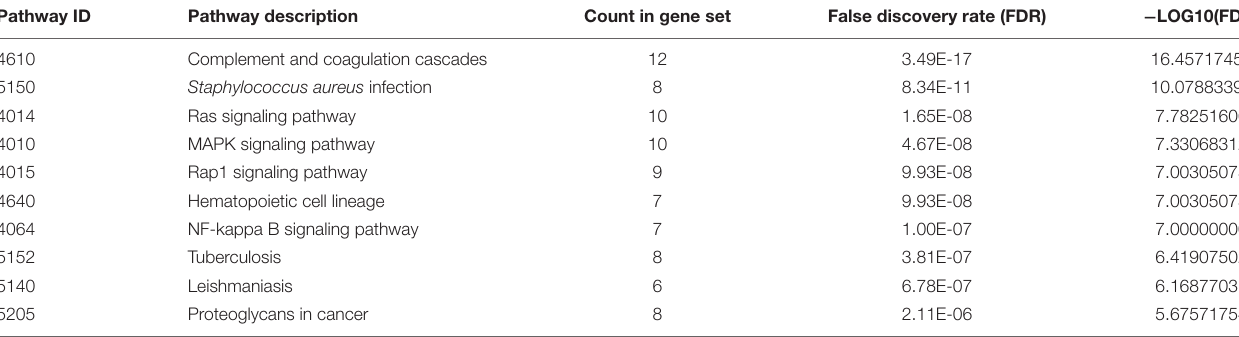
TABLE 1 | KEGG pathways analysis in the PPI network. Pathway ID Pathway